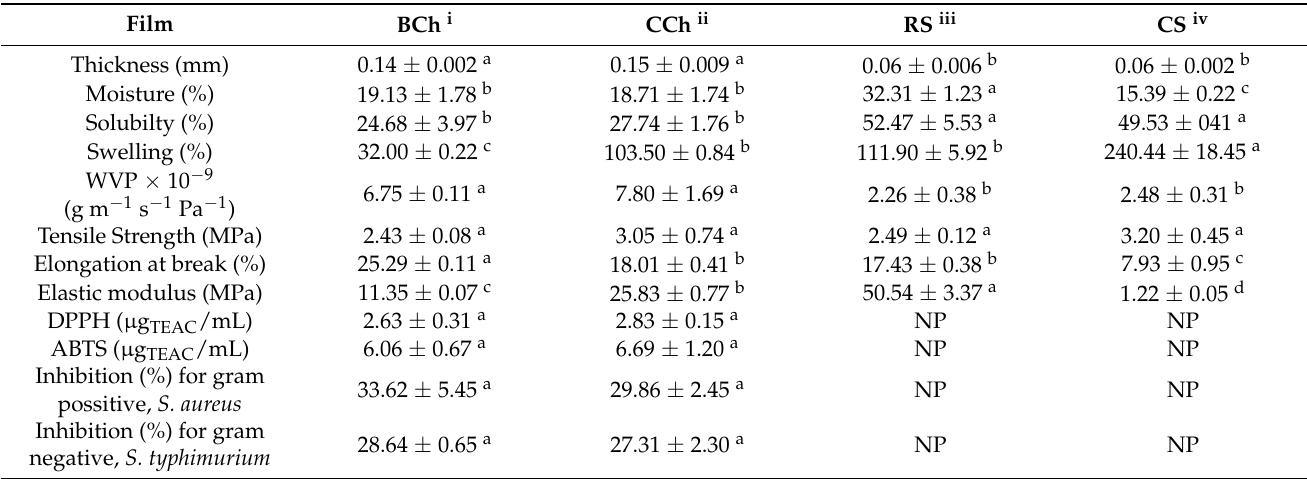
Table 1. Physicochemical and mechanical properties, antioxidant, and antimicrobial activities of BCh, CCh, RS and CS